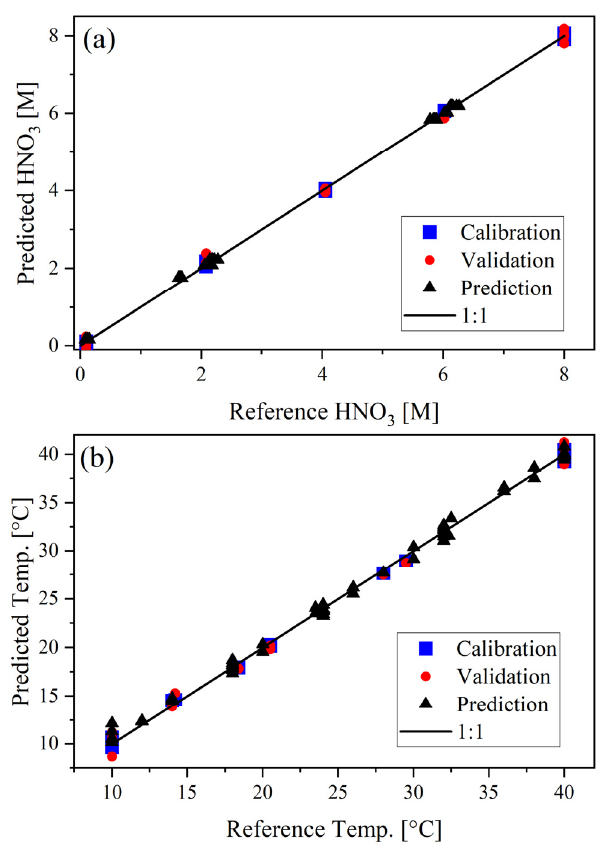
Figure 2. Calibration, cross-validation, and prediction parity plots for HNO 3 ( a ) concentration (M) and ( b ) temperature (°C). The model was built using the D-optimal calibration set and 4